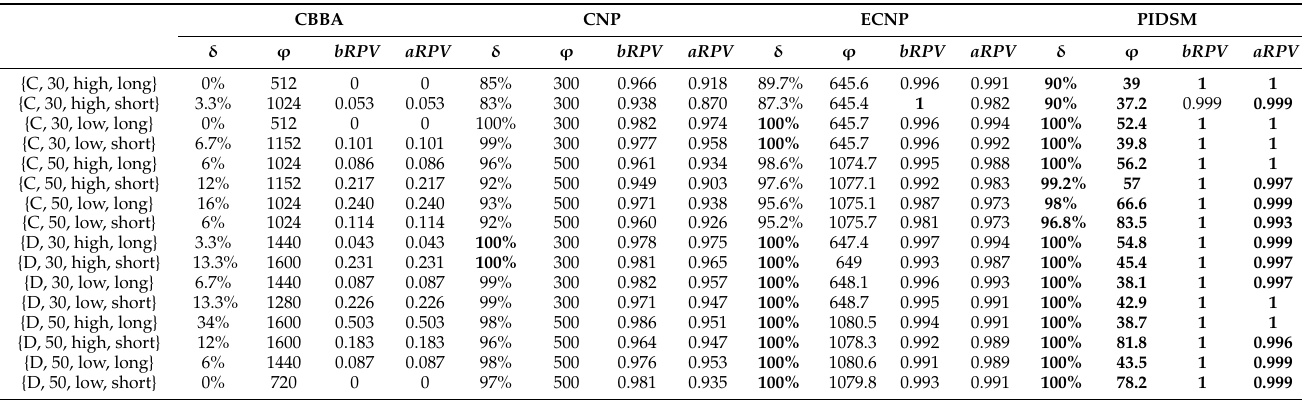
Table 6. The comparison results for medium-type instances.